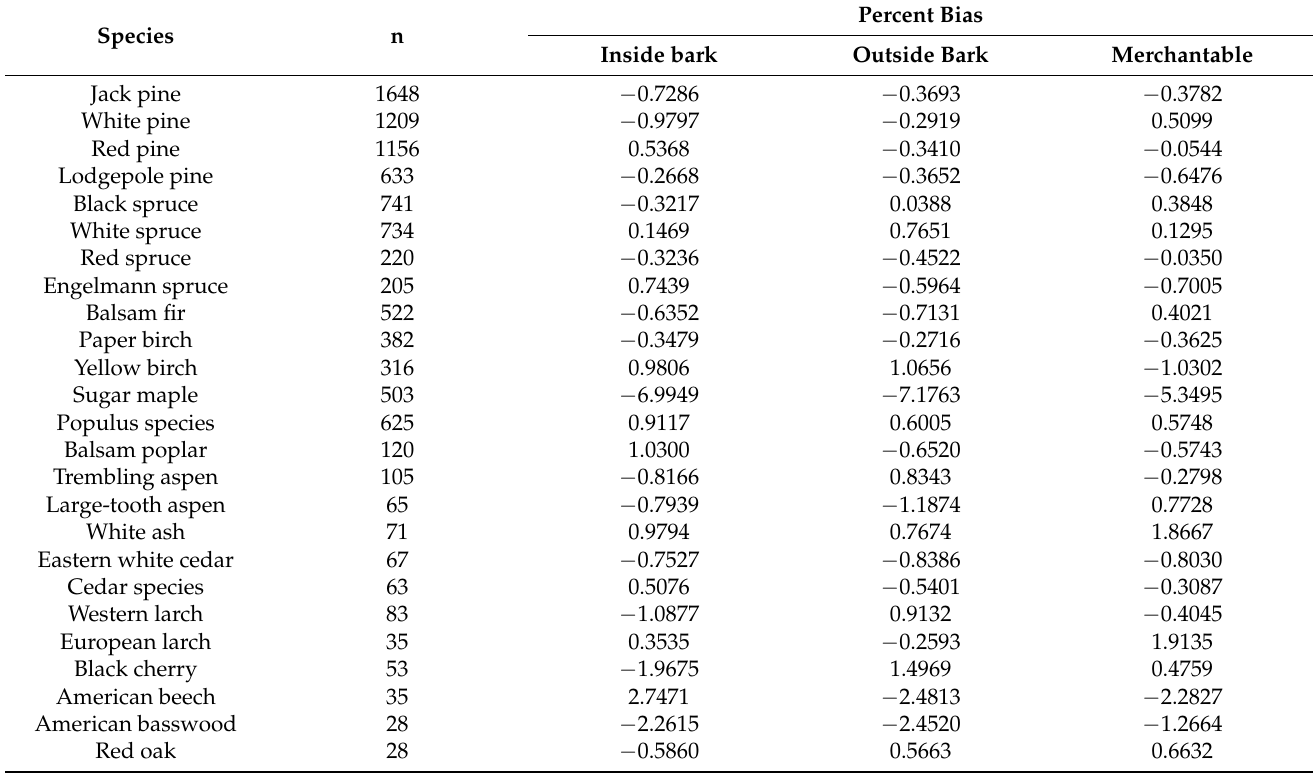
Table 7. Percent bias (observed − predicted) of the residuals for inside bark, outside bark, and merchantable volumes using Equation (10) for 25 tree species grown in Canada and the northeastern United